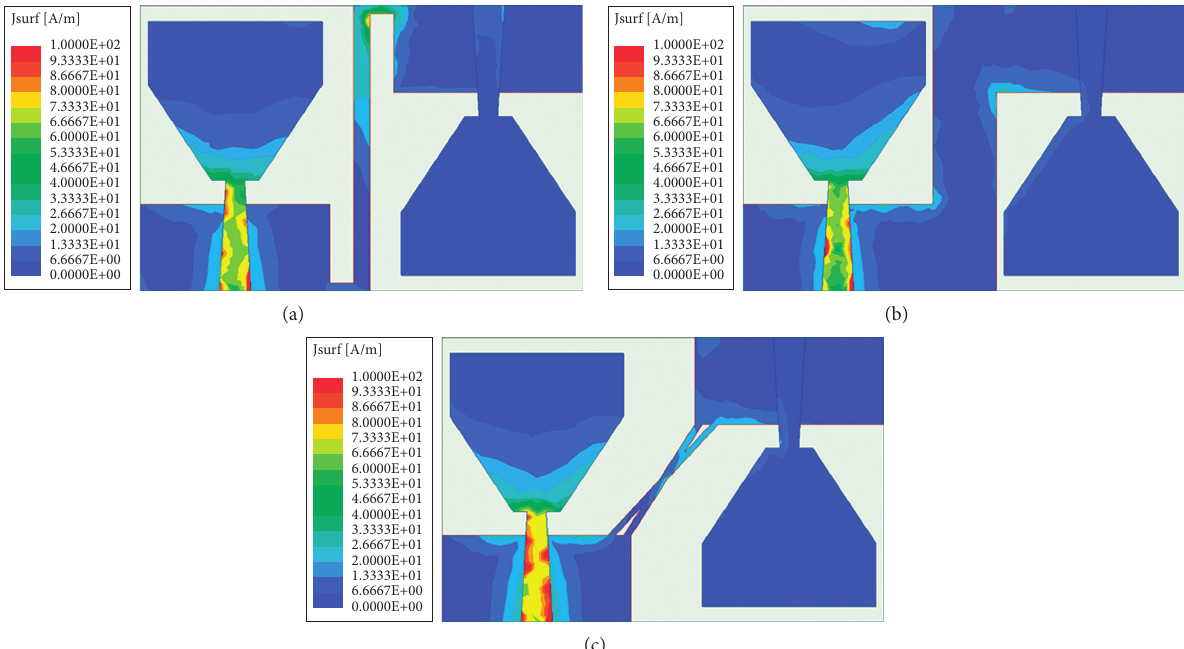
Figure 8: Surface current distribution diagrams of three antenna structures at 3 GHz. (a) A1. (b) A2. (c) A3.